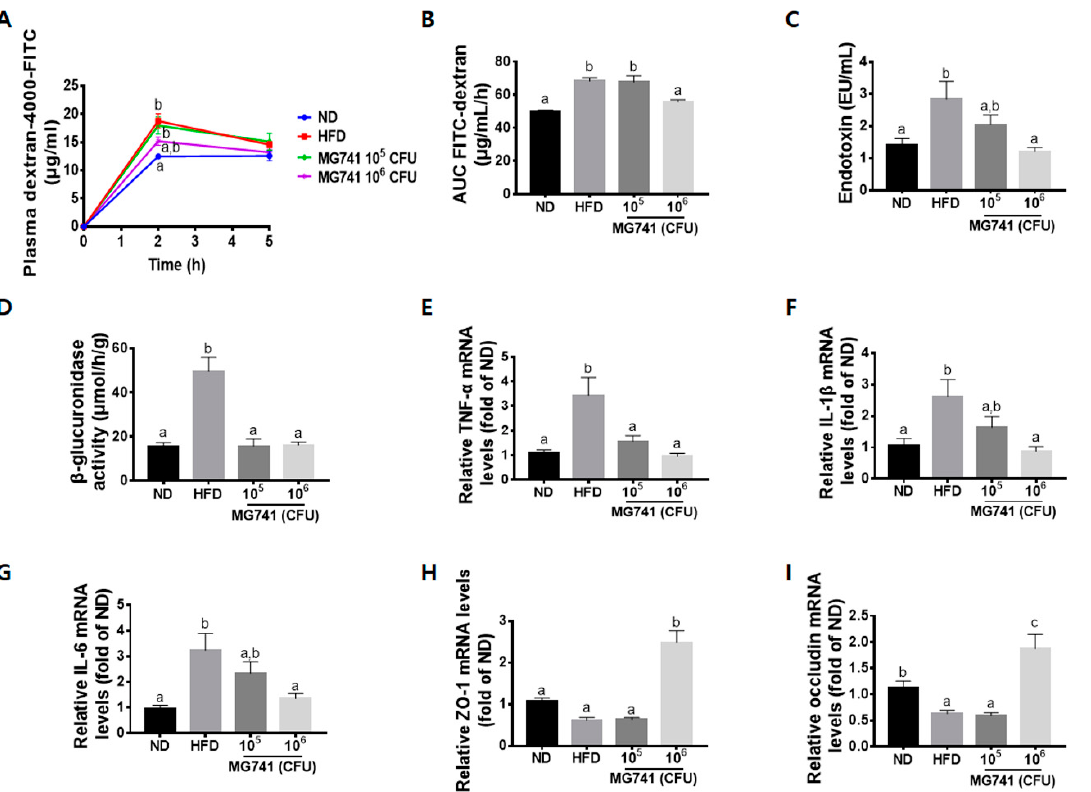
Figure 4. Bifidobacterium animalis ssp. lactis MG741 (MG741) improves high-fat-diet-induced changes in gut barrier function. ( A ) Plasma FITC-dextran concentration during the gut permeability test; ( B ) area under the curve of the plasma FITC-dextran levels; ( C ) plasma endotoxin; ( D ) β -glucuronidase activity; ( E ) relative mRNA expression of TNF- α ; ( F ) relative mRNA expression of IL-1 β ; ( G ) relative mRNA expression of IL-6; ( H ) relative mRNA expression of ZO-1; and ( I ) relative mRNA expression of occludin. Data are presented as the mean ± standard error of the mean ( n = 9). The different letters (a–c) indicate significant differences ( p < 0.05) determined by one-way ANOVA with Tukey’s post hoc tests.